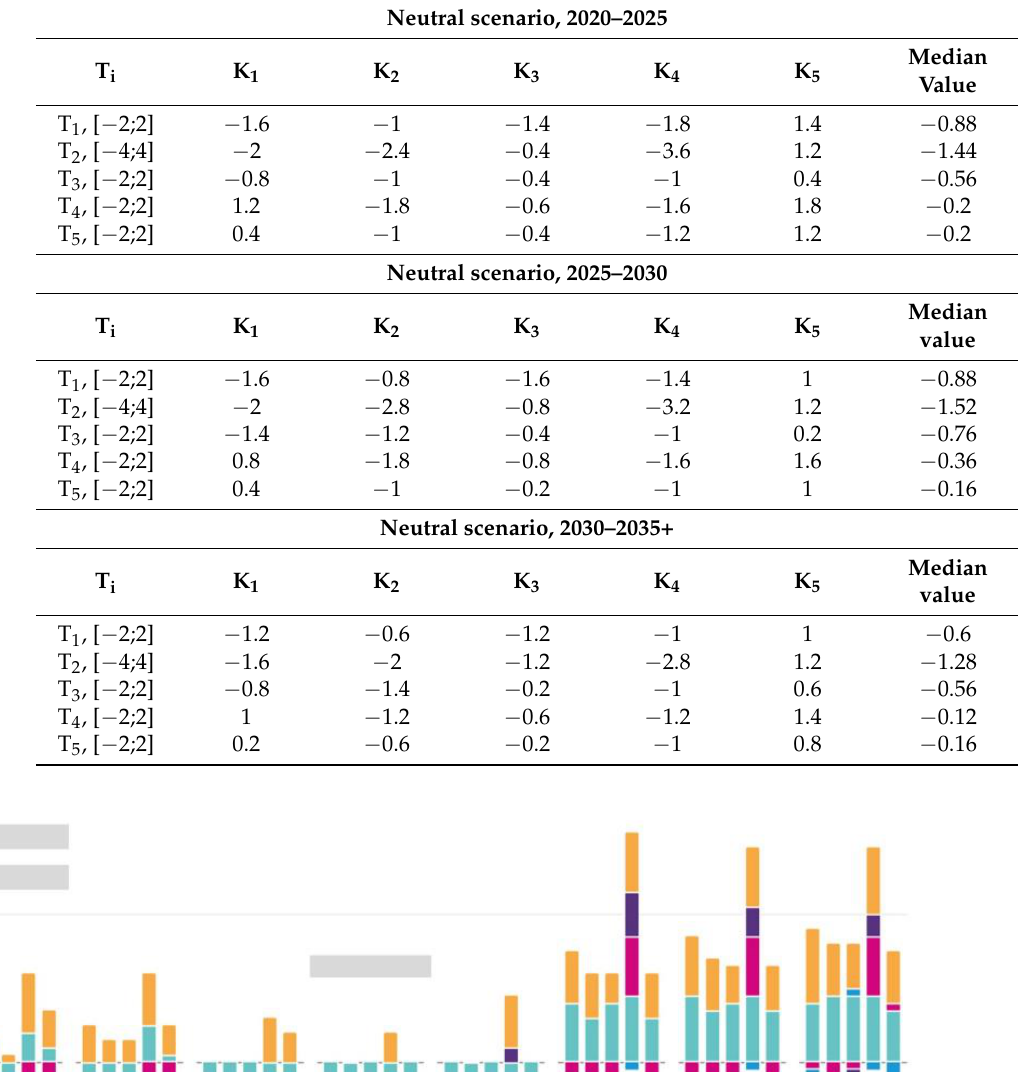
Table 3. Normalized assessments of properties within the framework of scenario criteria for the neutral scenario for the gas industry.